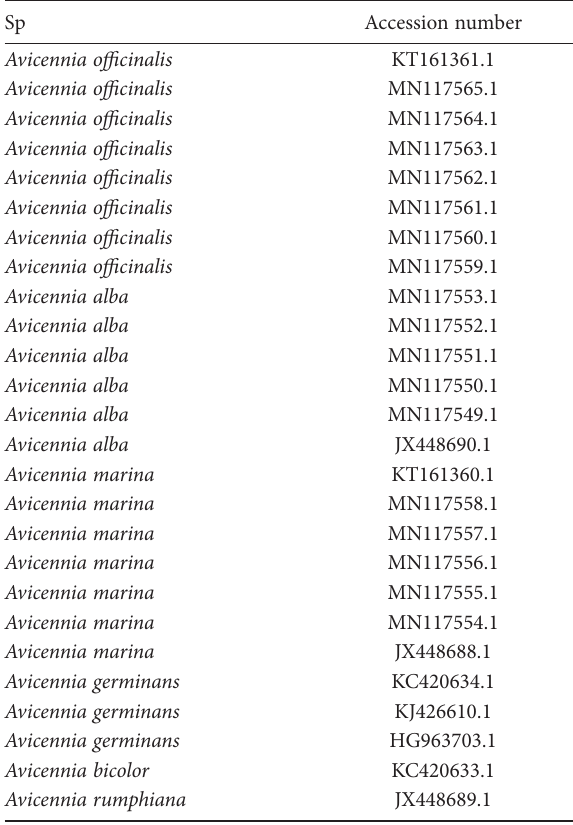
Table2 . Voucher information and GenBank accession numbers of taxa sampled for the genus Avicennia based on trnHG-psbA data.